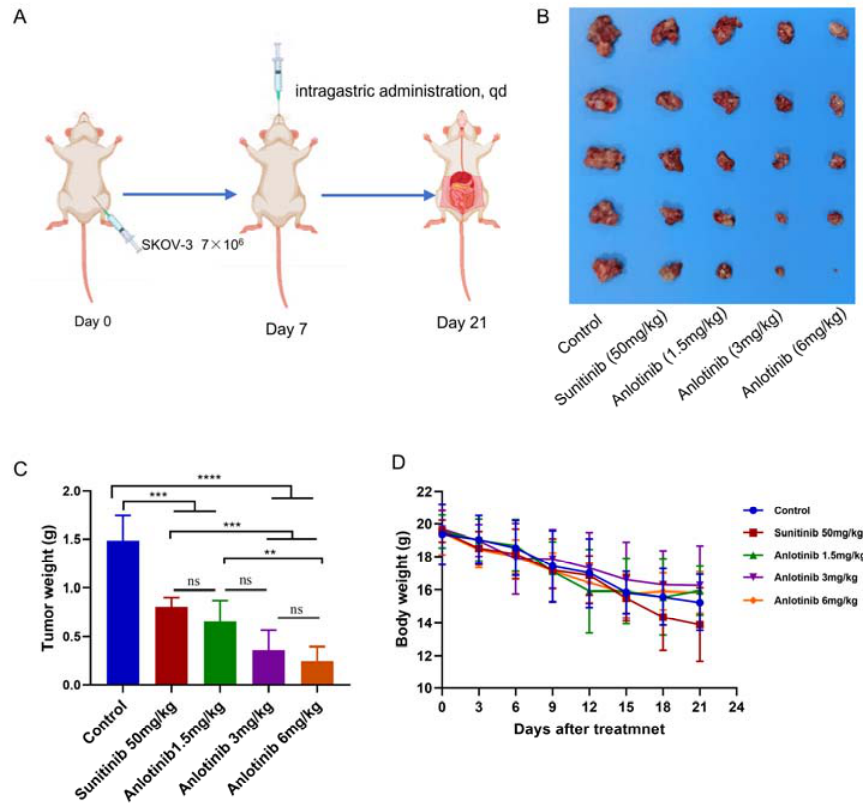
Figure 3. Anlotinib exhibited effective antitumor activity in vivo. ( A ) Timeline of the experiments in vivo. ( B ) SKOV-3 cells were intraperitoneally injected into female BALB/C-nude mice, which were treated with an oral dose of 1.5, 3 or 6 mg/kg anlotinib, 50 mg/kg sunitinib or vehicle once daily for 2 weeks. The image shows the sizes of tumors at the end of experiment. ( C ) The weights of tumors were measured. The data are presented as the mean ± SD. ** p < 0.01; *** p < 0.001; **** p < 0.0001; ns, non-significant. ( D ) Mice weights were calculated every 3